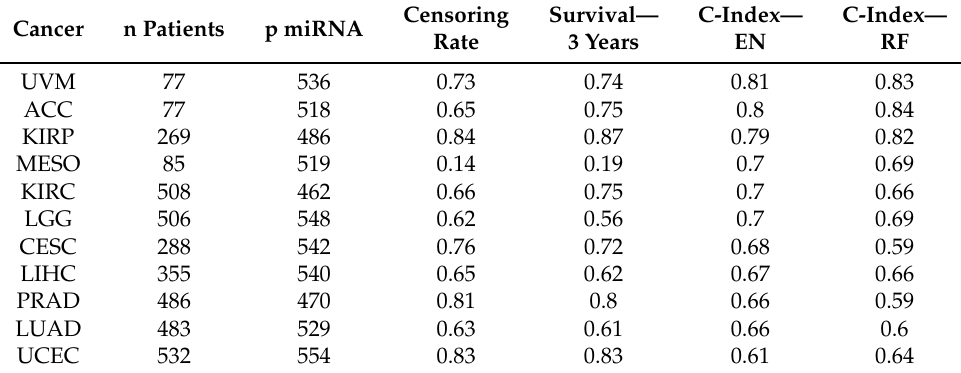
Table 1. Characteristics of the 11 cancers investigated. We computed the C-indices with 10 repetitions of 5-fold cross-validation for both the Cox-elastic net model (EN) and random survival forest (RF). Datasets are ordered according to their median C-index computed with Cox-elastic net model (decreasing